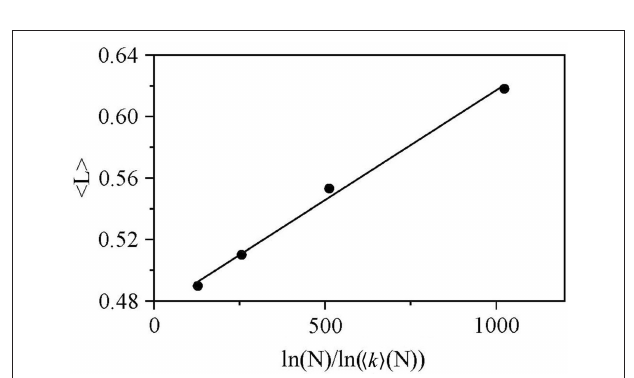
FIGURE 9 | Average path length plotted against ln(N)/ ln( h k i (N)) with best linear fit illustrated for β = 1 . 0 . This indicates the presence of the small-world